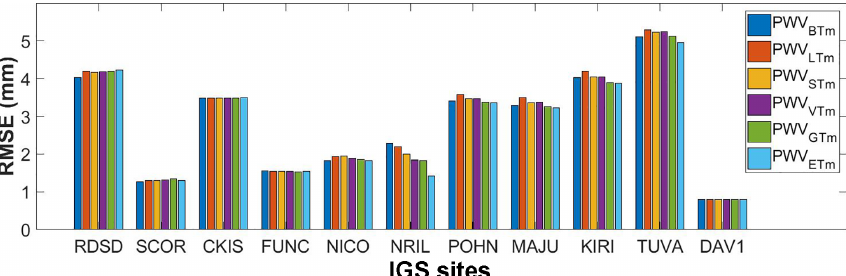
Figure 13. RMSEs of the PWV BTm , PWV STm , PWV VTm , PWV GTm and PWV ETm compared with the PWV RS at 11 IGS stations in 2016. PWV unit is millimeters.